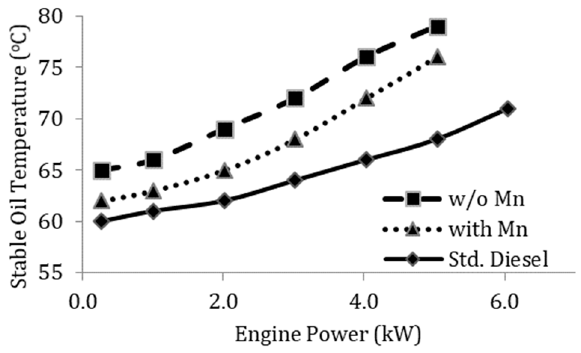
Figure 5. Effect of organic-based Mn additive on stable working temperature.